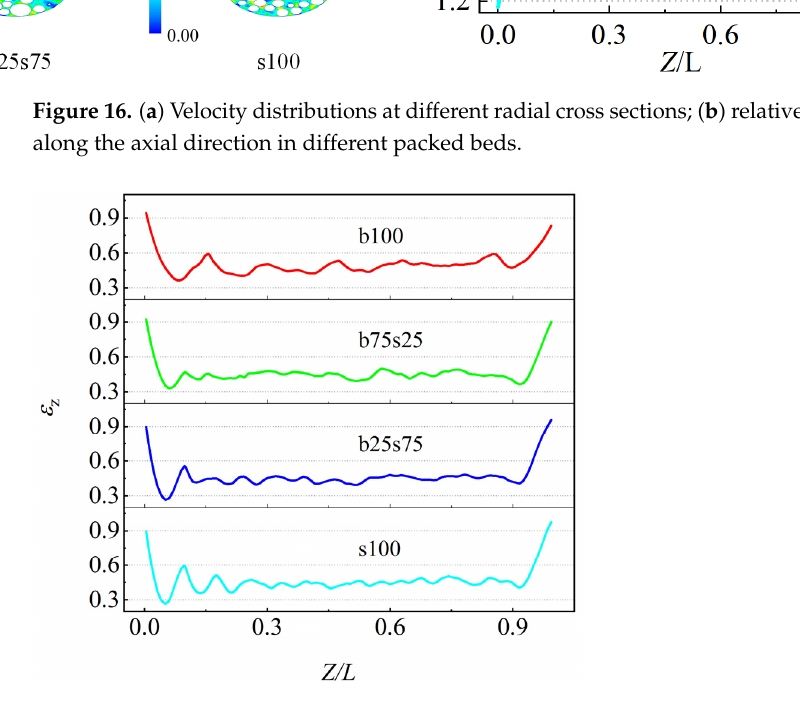
Figure 17. Axial porosity distribution.